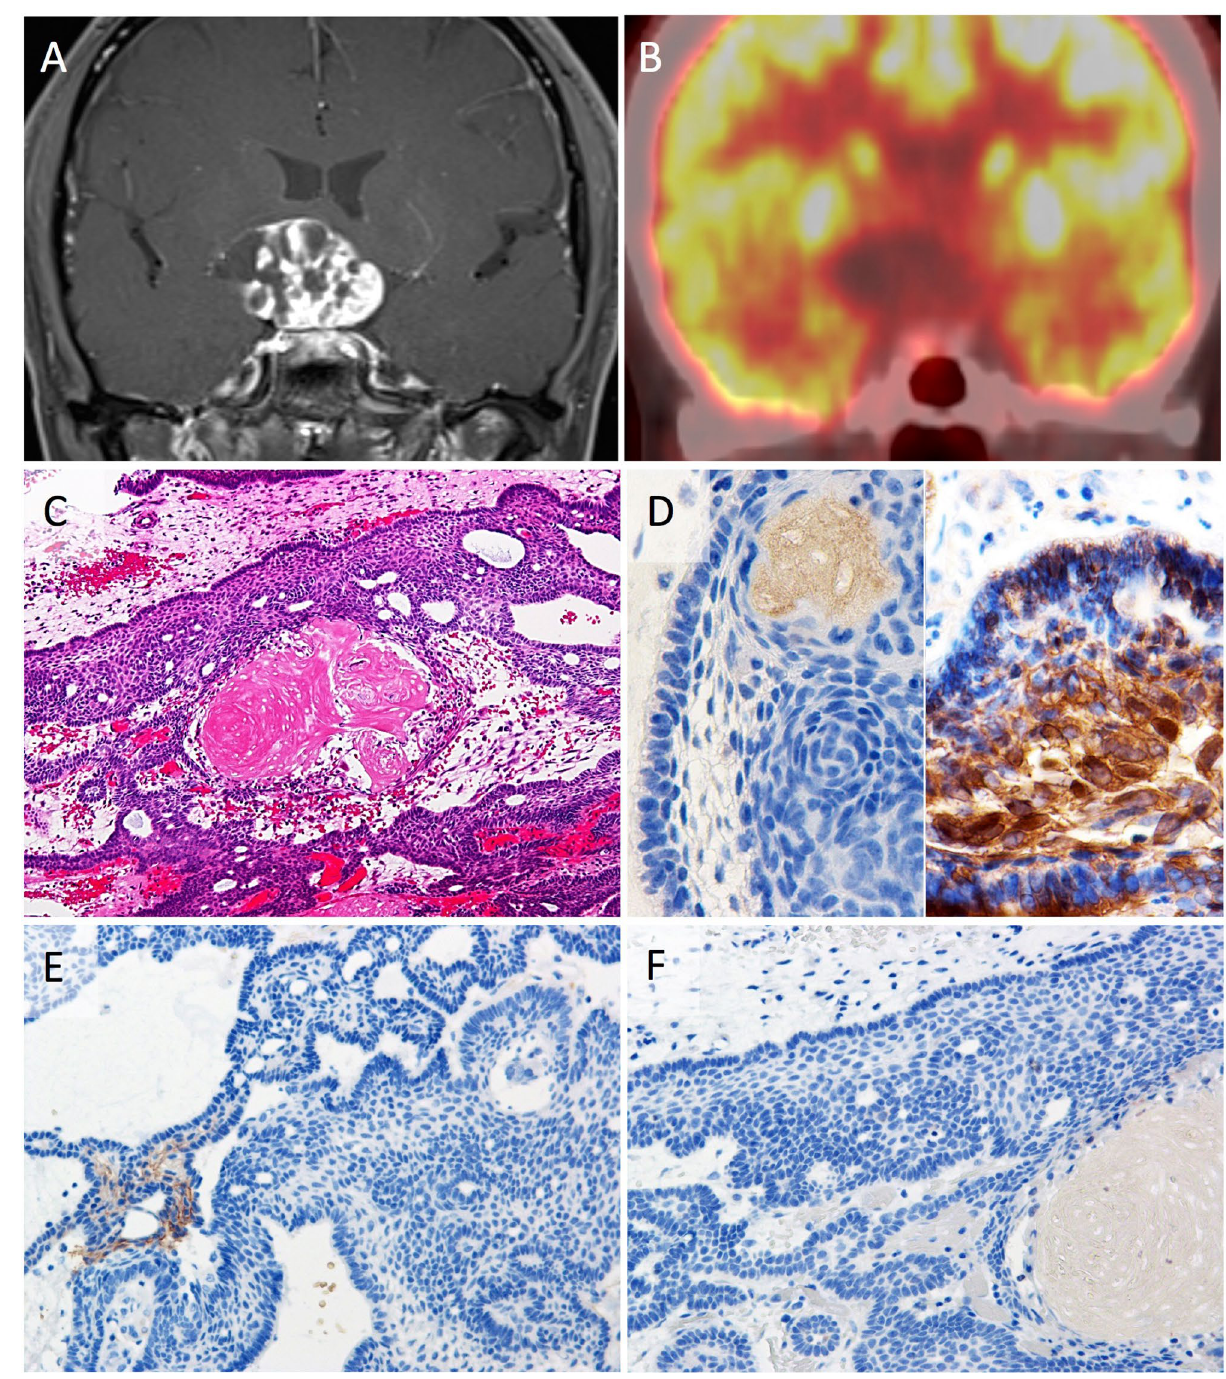
Figure 3. Case 2, a 39-year-old female patient with adamantinomatous craniopharyngioma. Preoperative coronal T1-weighted MR image after injection of gadolinium indicating a solid lesion with cysts in the suprasellar region ( A ). Preoperative FDG-PET coronal image demonstrating no glucose uptake in the suprasellar tumor ( B ). Pathologically, tumor with distinctive epithelium disposed in cords or lobules with basal palisading and wet keratin are detected ( C ) (hematoxylin and eosin, original magnification ×100). BRAF V600E is negative for tumor cells ( D ; left, ×400) and aberrant nuclear expression of beta-catenin is found ( D ; right, ×400). GLUT-1 expression is very focally detected ( E , ×200). HX-II expression is not seen ( F ,